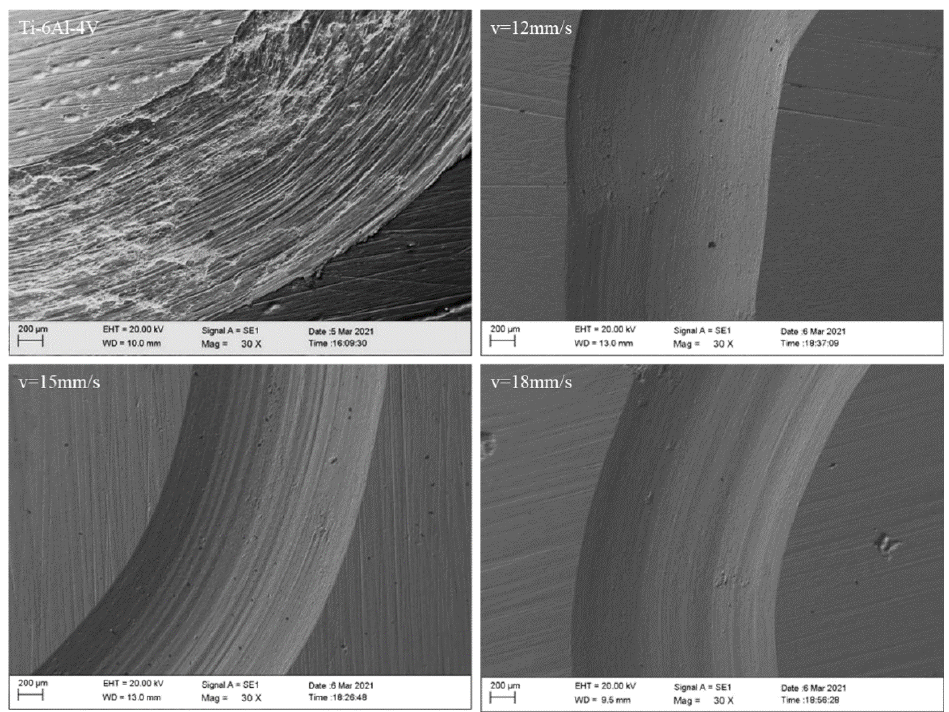
Figure 10. Wear surface morphologies of the substrate and coatings with different laser scan speeds.